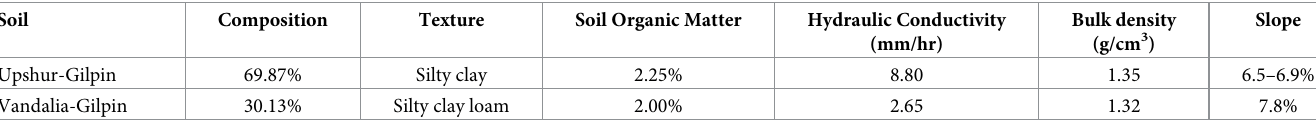
Table 2. Soil properties for the case study (from websoilsurvey.sc.egov.usda.gov). Soil